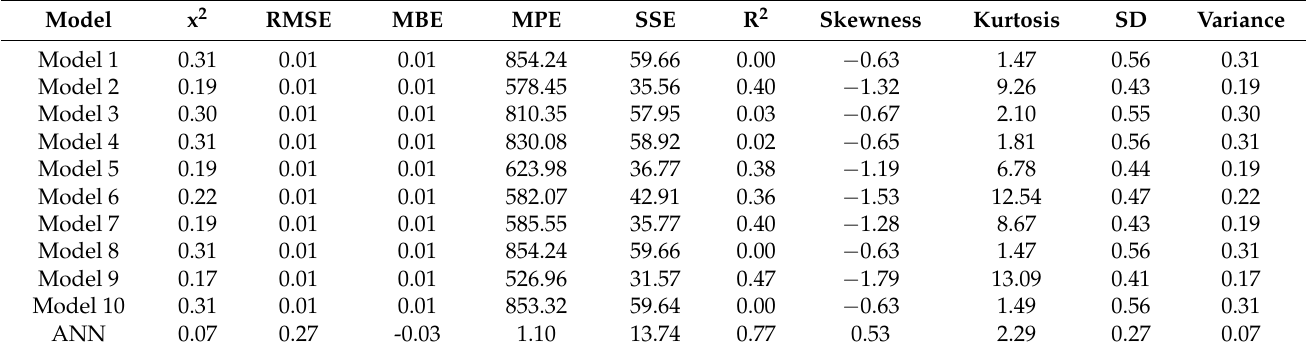
Table 3. Statistical test goodness of fit (developed regression